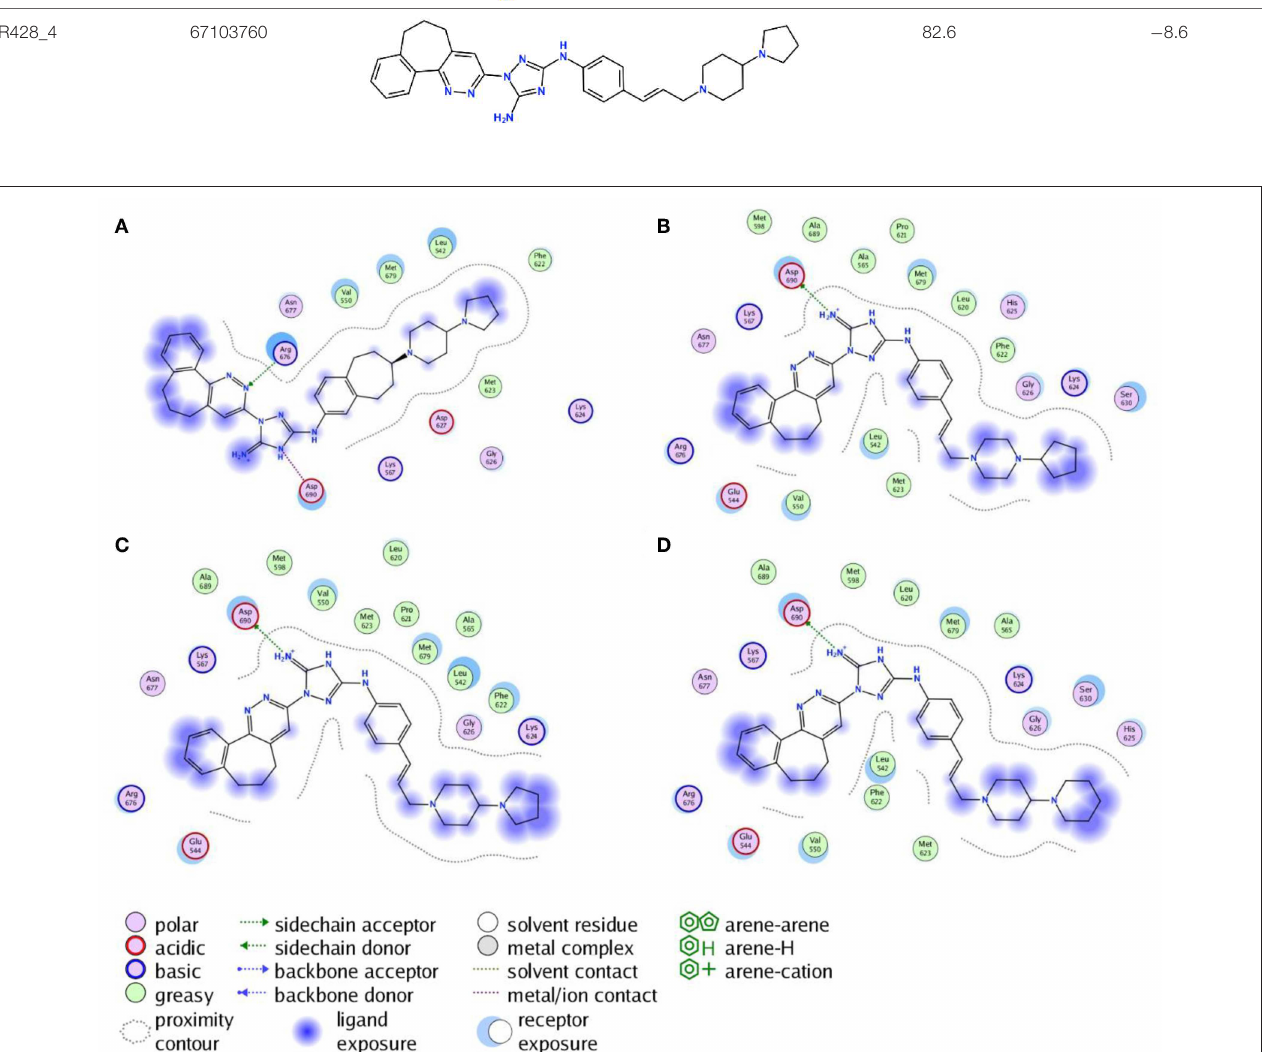
FIGURE 2 | The 2D interaction diagrams of the R428_1 (A) , R428_2 (B) , R428_3 (C) , and R428_4 (D) compounds with the Axl kinase pocket.